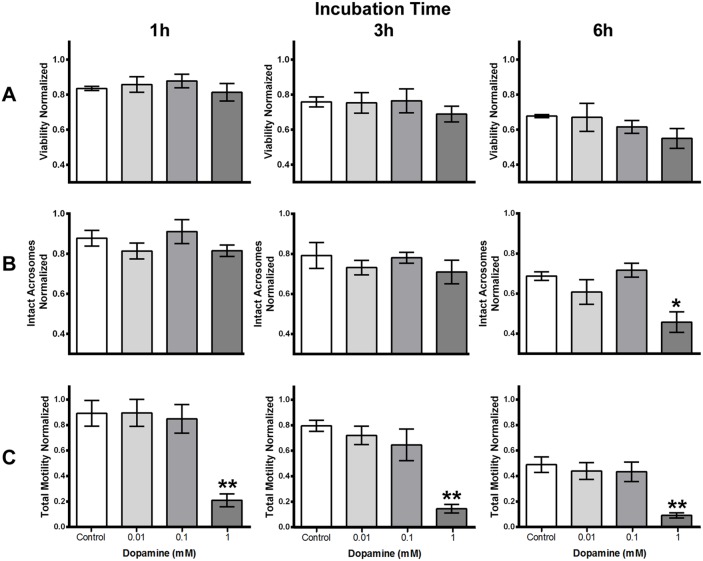
High doses of dopamine reduce sperm motility and acrosomal integrity without affecting the sperm viability over time.
A) Effect of dopamine on sperm viability at 1, 3 and 6 hours of incubation. Equine sperm were incubated at 37°C with different concentrations of dopamine (0, 0.01, 0.1 and 1 mM) in Withenn’s buffer and the quantity of viability sperm was calculated using a CASA system, with a minimum of 500 sperm analyzed per experiment. Sperm viability at different times of analysis was normalized to time zero of the control. Results are the mean ± SEM of four independent experiments. B) Effect of dopamine on acrosomal integrity after 1, 3 and 6 hours of incubation. Equine sperm were incubated at 37°C with different dopamine concentrations (0, 0.01, 0.1 and 1 mM) in Withenn’s buffer (enrichment with BSA and bicarbonate) and the percentage of sperms with intact acrosomes was assessed with PSA-FITC staining and by cell count under an epifluorescence microscope. A minimum of 200 sperm were counted. The percentage of intact acrosomes was normalized to time zero of the control without dopamine. Results are the mean ± SEM of four independent experiments. *p<0.05 with respect to the control. C) Effect of dopamine on total sperm motility after incubation for 1, 3 and 6 hours. Equine sperm were incubated at 37°C with different concentrations of dopamine (0, 0.01, 0.1 and 1 mM) in Withenn’s buffer and the quantity of mobile sperm was calculated using a CASA system. A minimum of 500 sperm were analyzed per experiment. Total motility at different times of analysis was normalized to time zero of the control. Results are the mean ± SEM of four independent experiments. **p<0.01 with respect to the control.